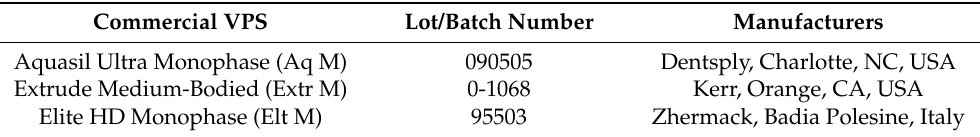
Table 1. Commercial VPS impression materials used in this study.